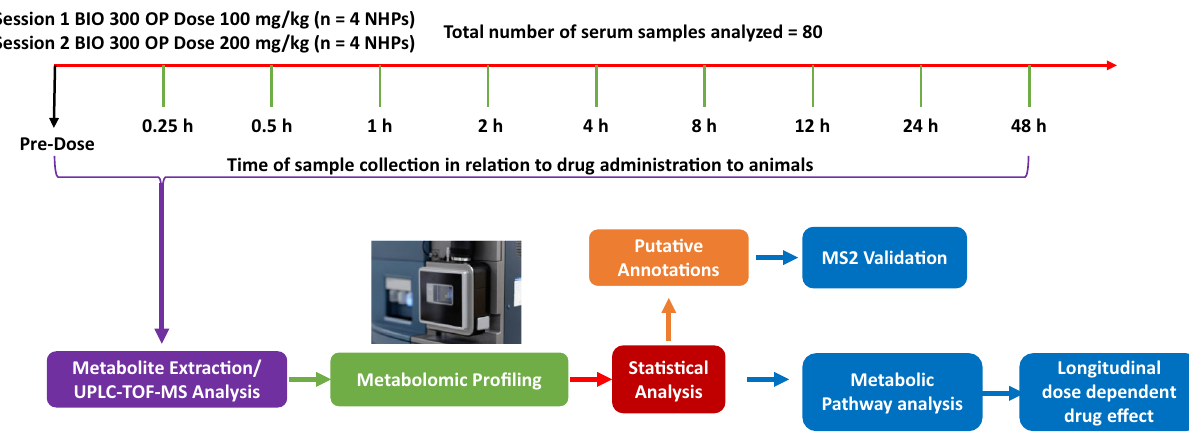
Figure 1. Overall study design schema for metabolic and PK examination following BIO 300 Oral Powder administration to